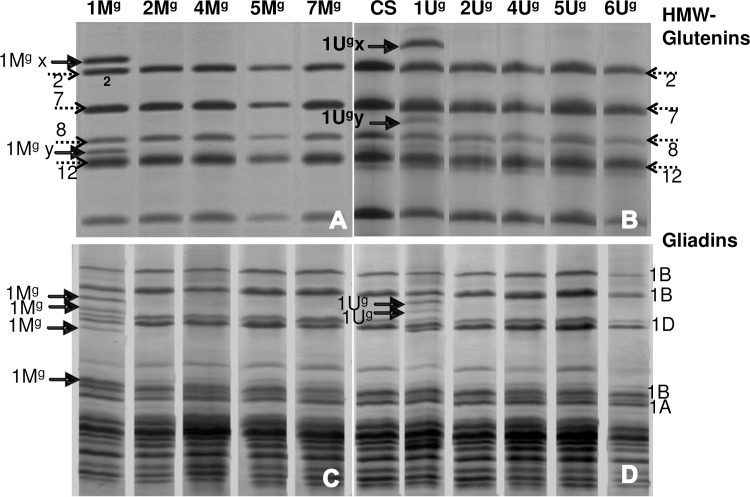
Seed storage protein profiles of different DALs of Ae. geniculata.A & B; HMW-GS profile, C & D; gliadin profile. DAL1Mg and DAL1Ug revealed additional HMW-GSs and gliadins (indicated by arrows).